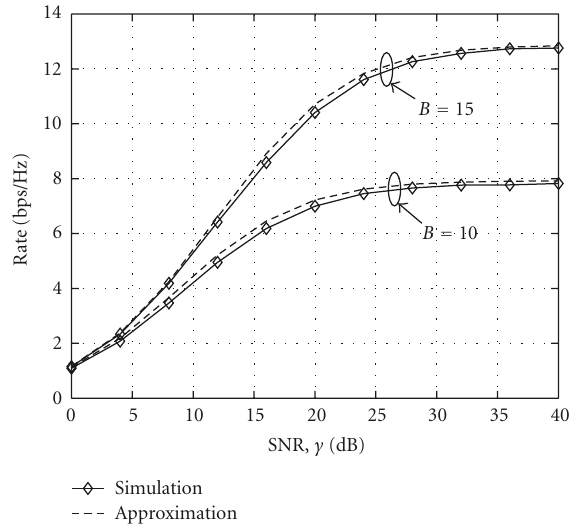
Figure 1: Approximated and simulated ergodic rates for the ZF precoding system with limited feedback, N t = U =